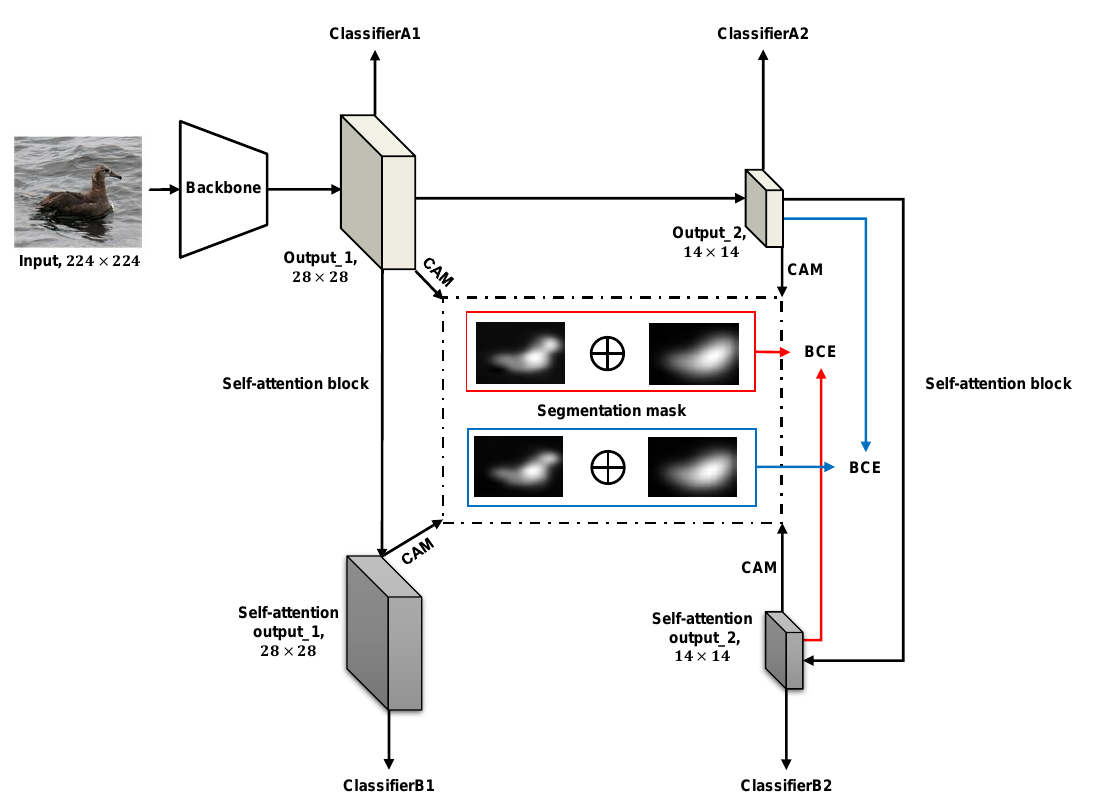
Figure 1. Overview of our proposed two-branch network. Class activation maps (CAMs), binary cross entropy (BCE).